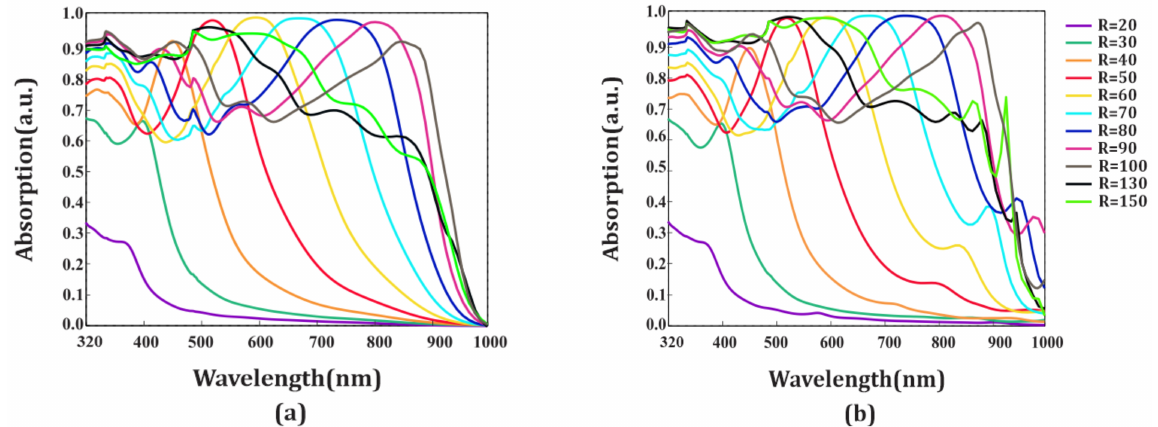
Figure 7. Absorption spectra for varying radius for ( a ) bare cell and ( b ) proposed cell.